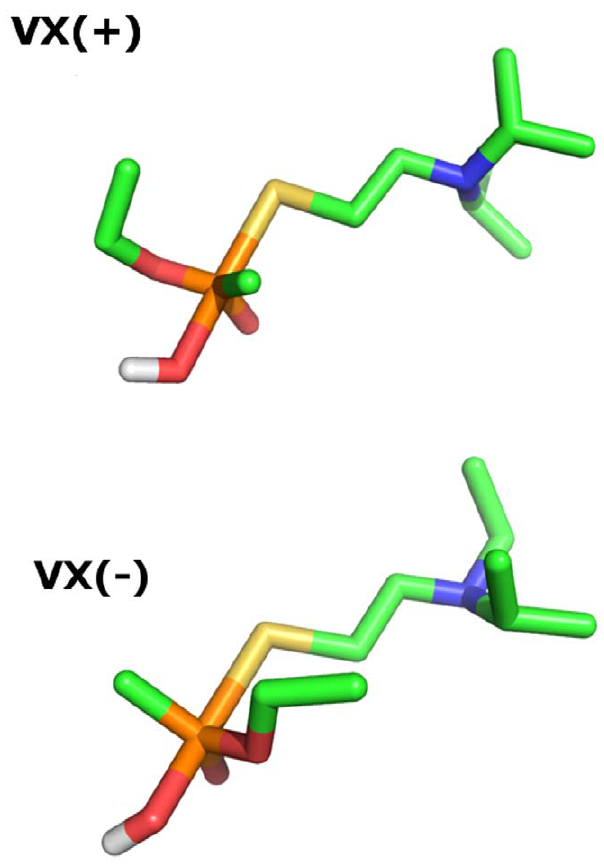
Figure 2. The transition state conformations for VX P( + ) and VX P( 2 ). The structures were generated with the QM/MM capabilities of the AMBER molecular dynamics suite [21]. doi:10.1371/journal.pone.0020335.g002 SER/SMD structure of HuPON1 in combination with the D269 mechanism and either VX ts P( 2 ) or VX ts P( + ) have greater than 95% probability that their correlation values will be higher than 80 random correlation values. Thus, across the methods tested, only those that are based on the D269 hydrolysis mechanism have significant correlation with the experimental data. Higher correlation values are observed with VX ts P( 2 ) than VX ts P( + ). Table 2. Top scoring parameters by correlation analysis.